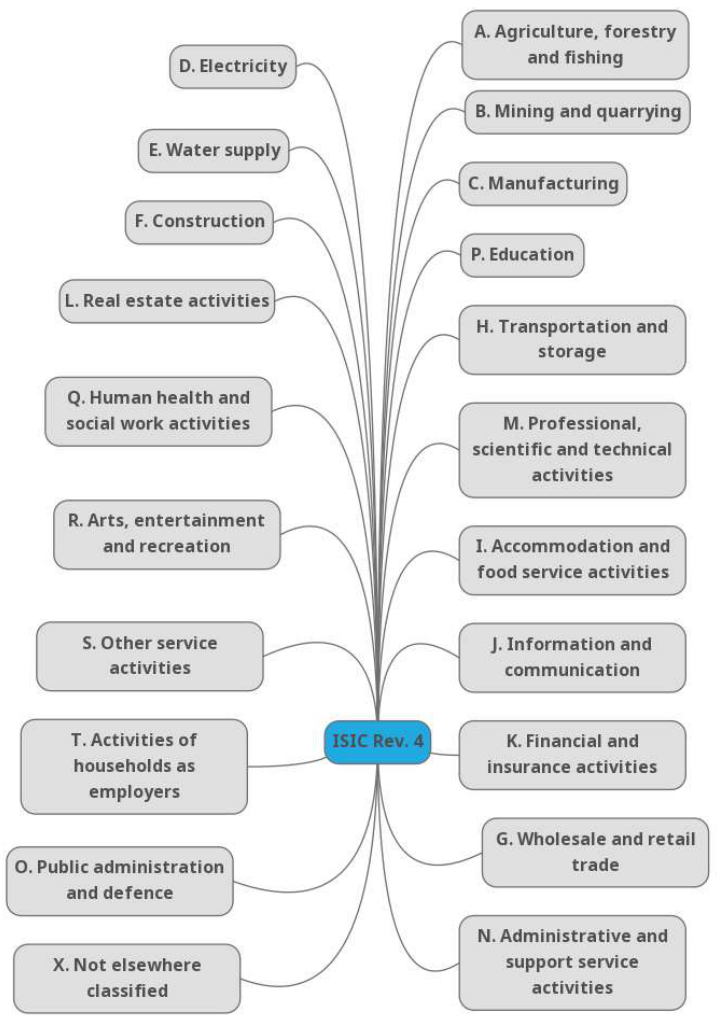
Figure 2. Sectors of activity represented in ISIC